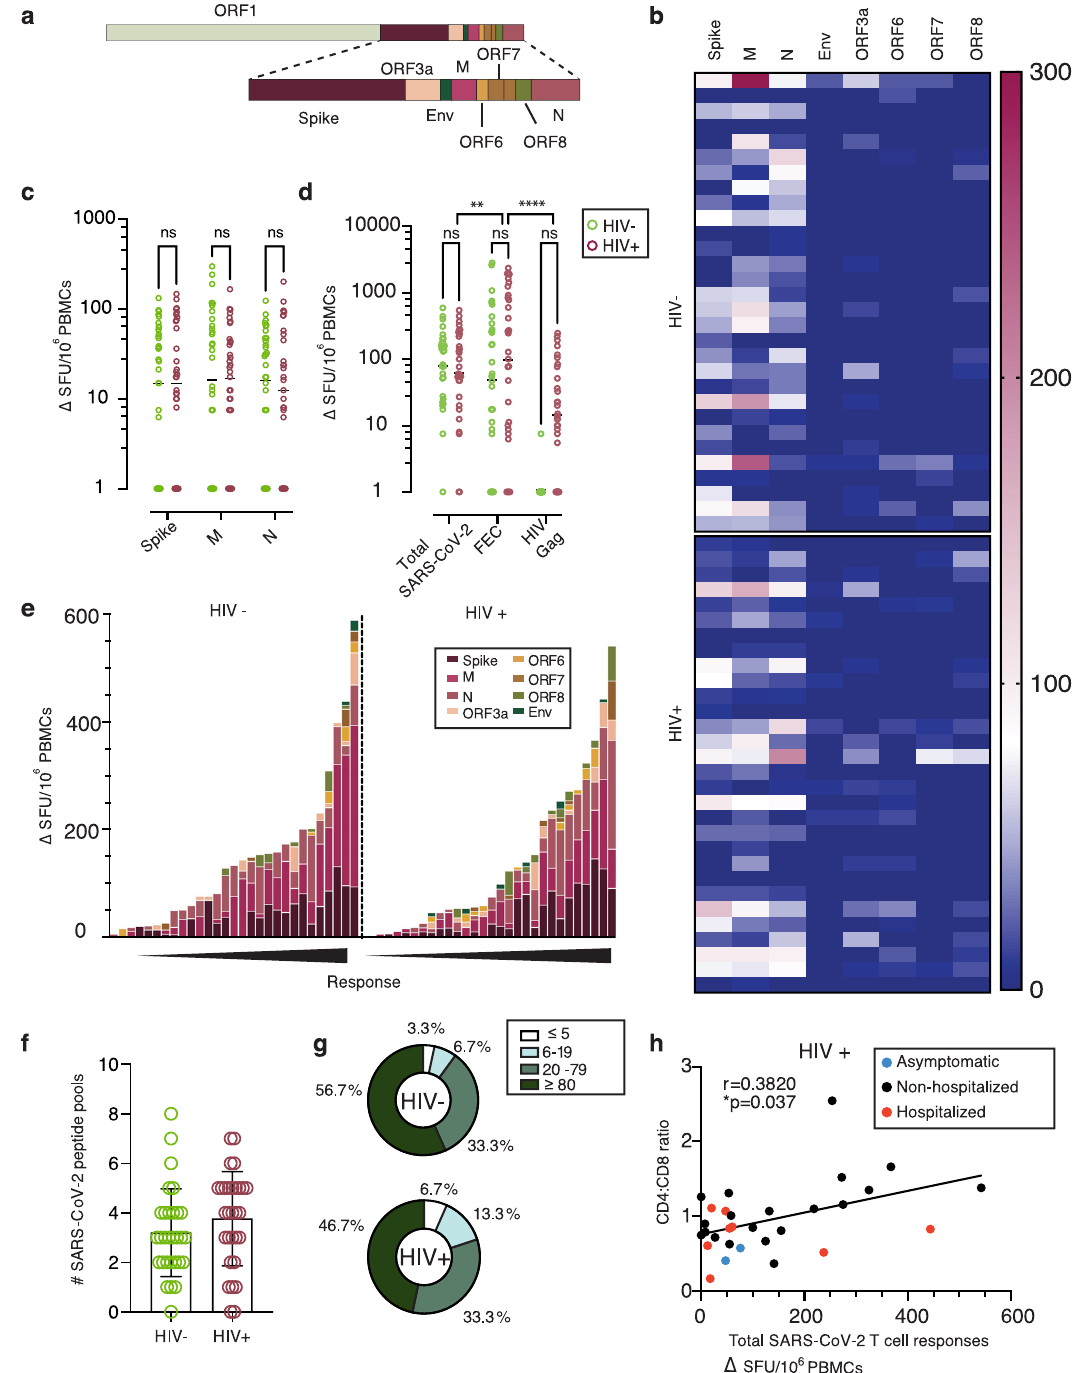
SARS-CoV-2-speci fi c T-cell responses are dominated by CD4 T cells . Following the initial broad screening of the antiviral responses to SARS-CoV-2, intracellular cytokine staining (ICS) was used to assess the composition and polyfunctionality of T-cell responses in a group of HIV-positive ( n = 11) and HIV-negative ( n = 12) donors with available PBMC and detectable responses by IFN- γ -ELISpot. To determine the functional capacity of SARS- CoV-2-speci fi c CD4 and CD8 T cells, we stimulated PBMCs with overlapping Spike, M and N (non-Spike) peptide pools, in addi- tion to CMV pp65 and HIV gag peptides within the same indi- viduals. We focused on Spike, M and N as these antigens dominated responses detected by ELISpot. Expression of the